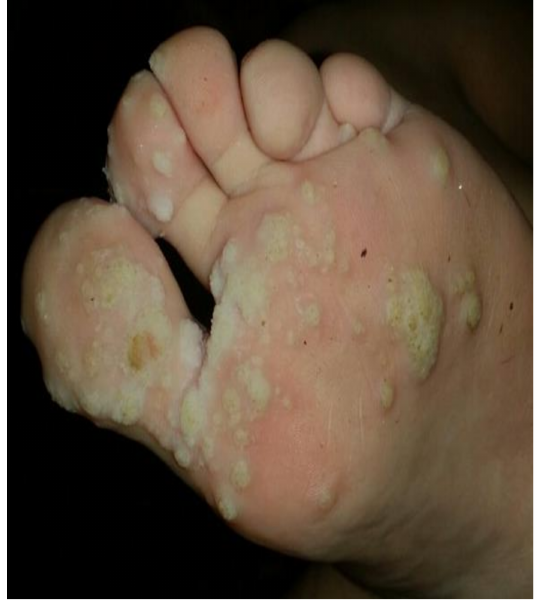
Figure 2. Verruca plantaris (Patient